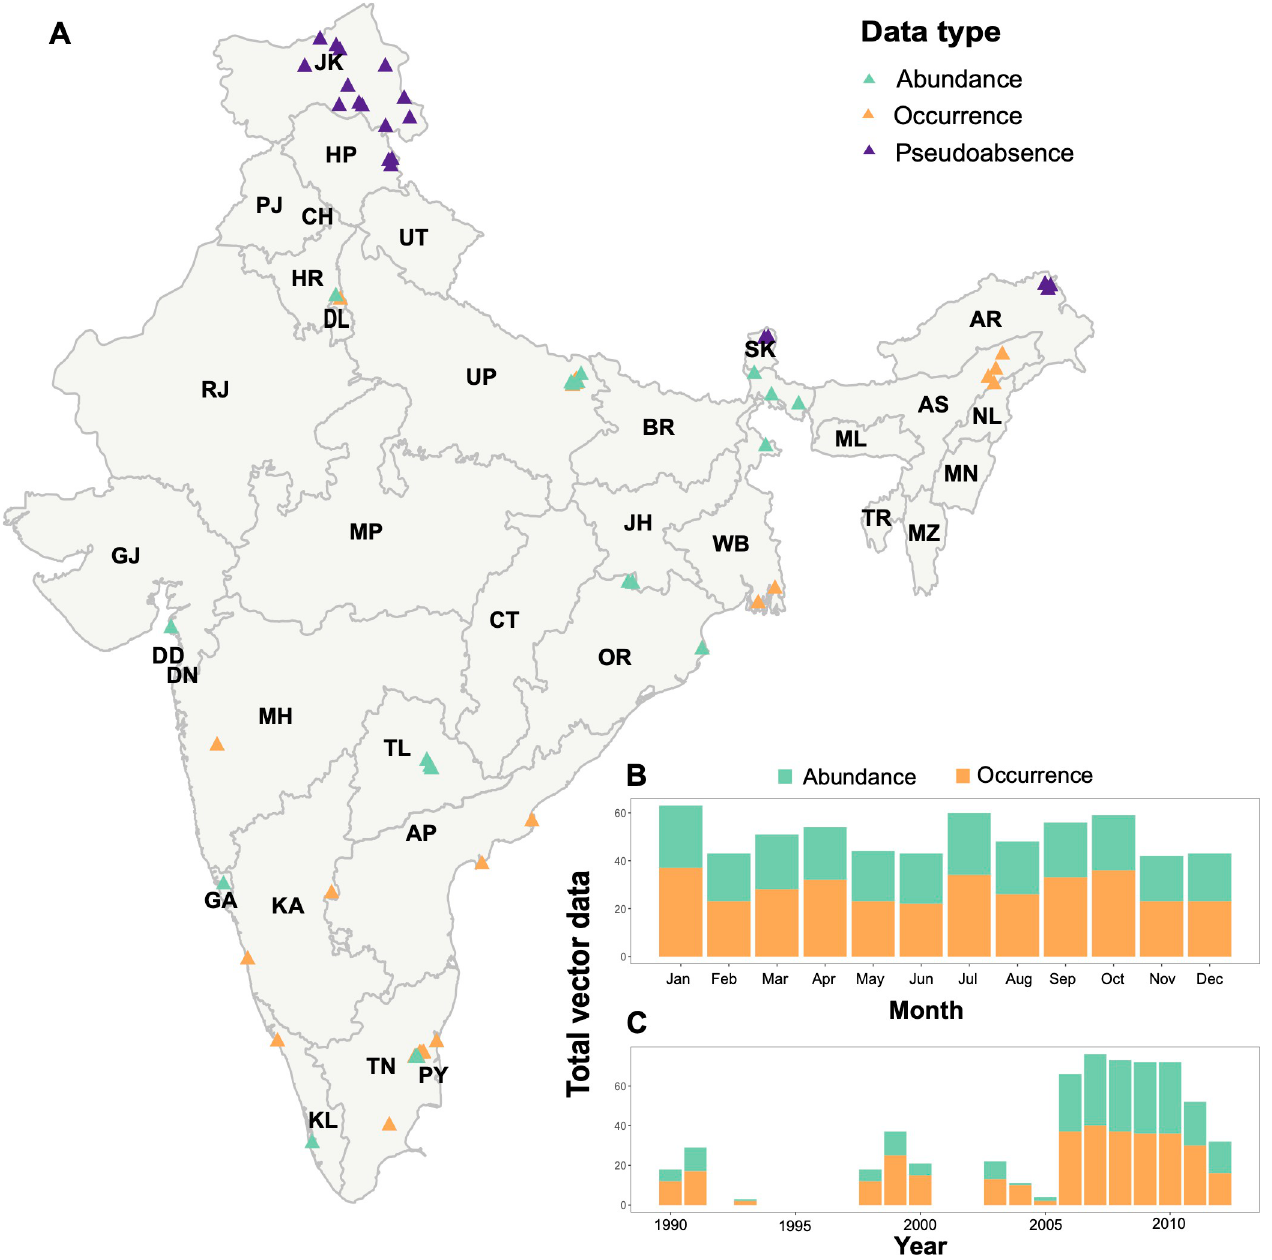
Fig 1. Spatial and temporal distribution of vector surveillance dataset used in model. (A) Points show the geographical sampling locations (n = 57) of the C. tritaeniorhynchus records across India � , with occurrence-only records coloured orange (n = 74), records which included occurrence and abundance data in green (n = 266), and pseudoabsence records in purple (n = 20). Stacked barplots show the temporal distribution of the total vector occurrence (orange) and abundance data (green) used in the analysis per month (B) and year (C). � Abbreviations for Indian states and union territories: AP—Andhra Pradesh,